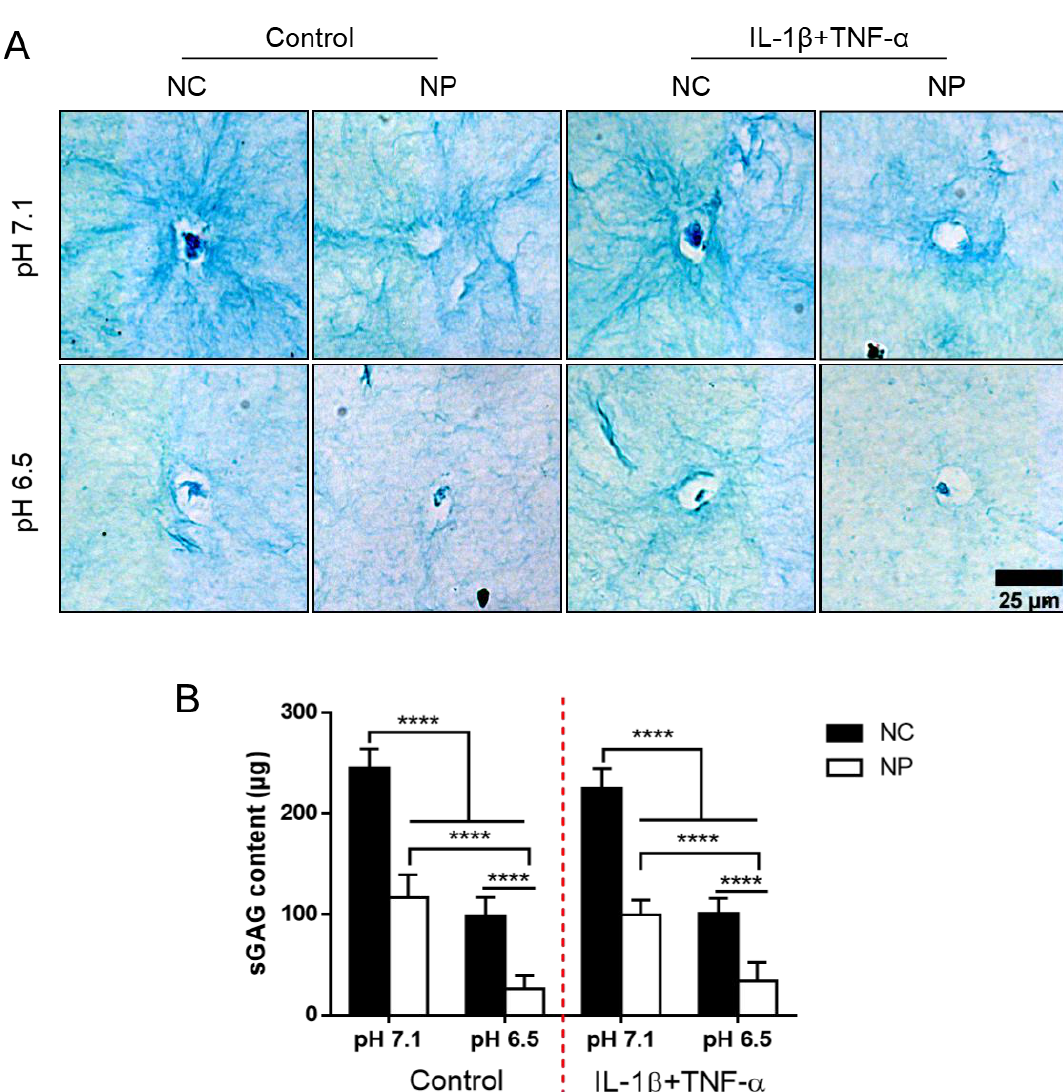
Figure 6. ( A ) Histological evaluation of hydrogels with alcian blue to identify sGAG at day 14 of NCs and NP cells in 3D hydrogel culture at different pH (7.1 and 6.5) and inflammatory cytokine (IL-1β+TNF-α) supplementation conditions. Scale bar is 25 μm. ( B ) sGAG (μg) produced by NCs and NP cells in 3D hydrogels. Values were calculated by subtracting day 0 content from day 14. **** ( p < 0.0001) indicates significant differences between groups. N = 3 donors, n = 3 samples.